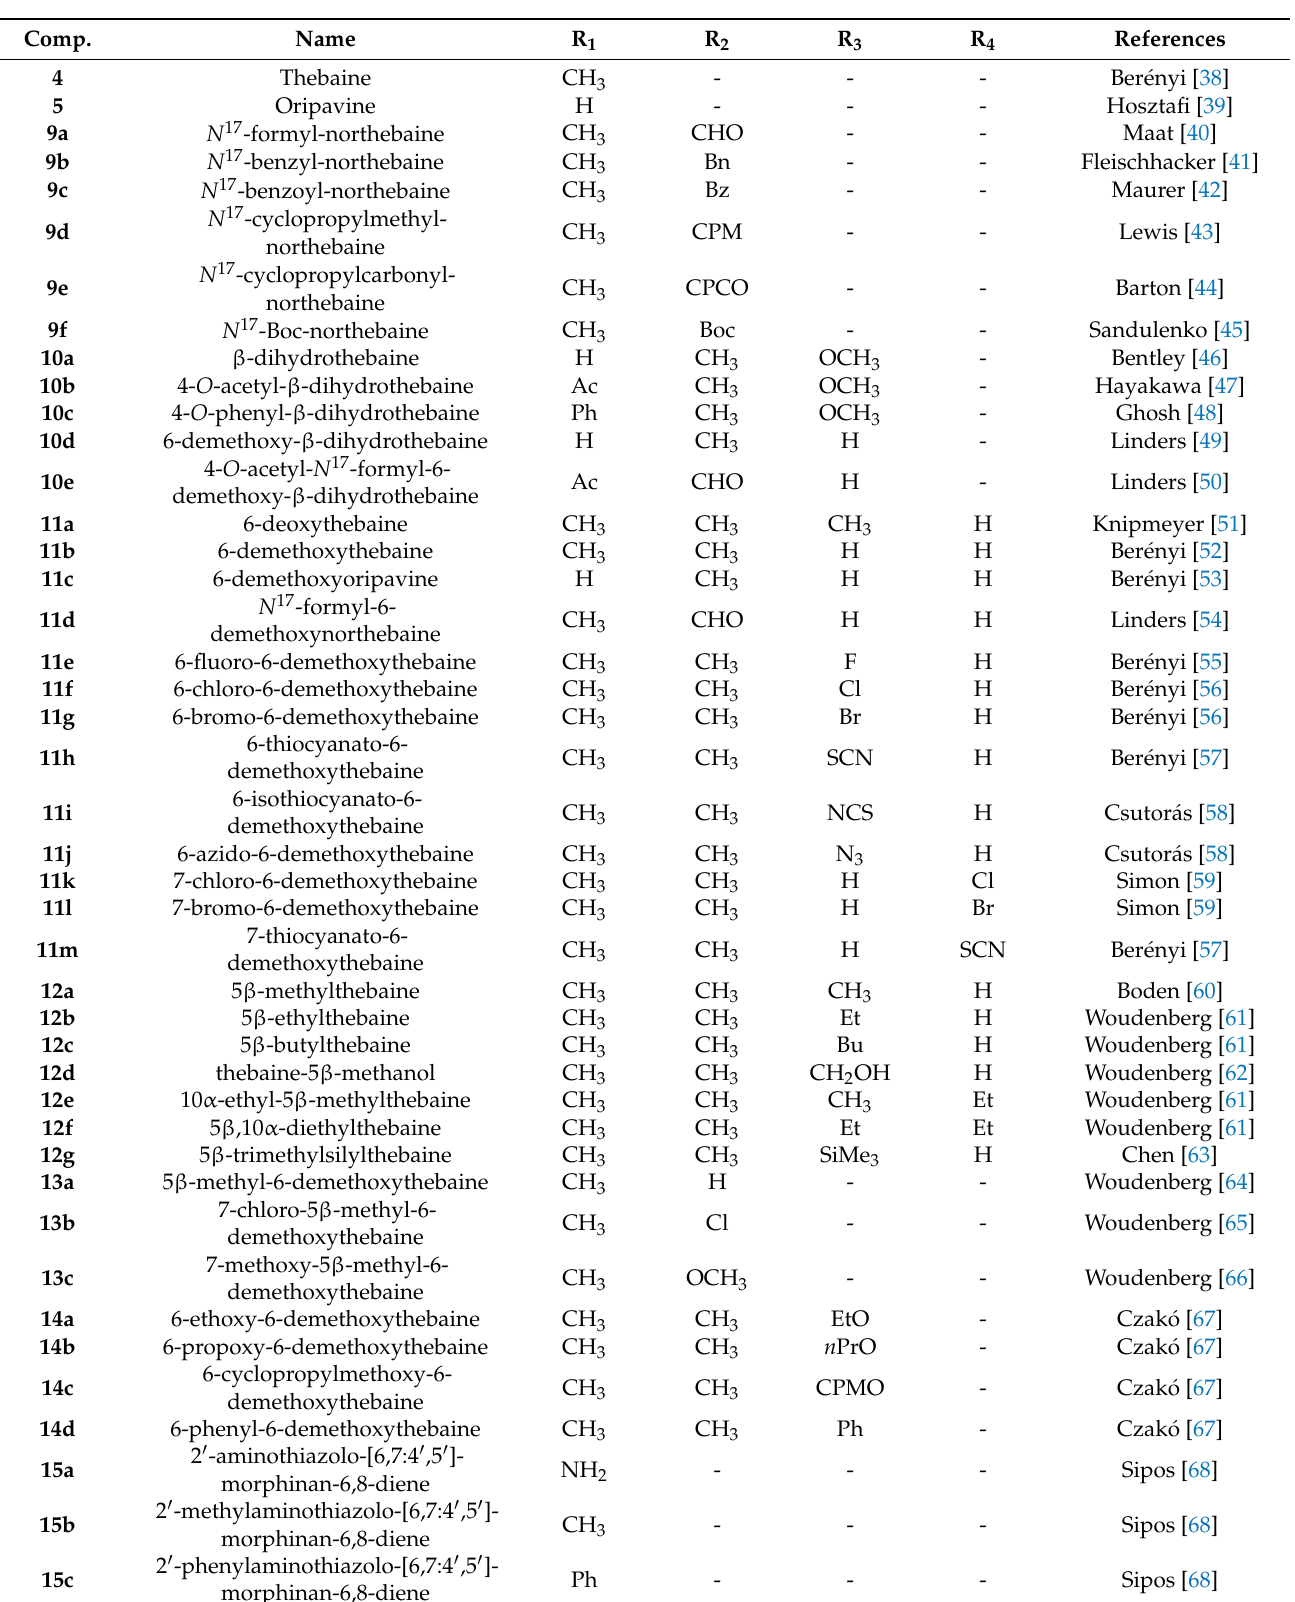
Table 1. Definition of the substituents of morphinan-6,8-dienes depicted in Figure 2.